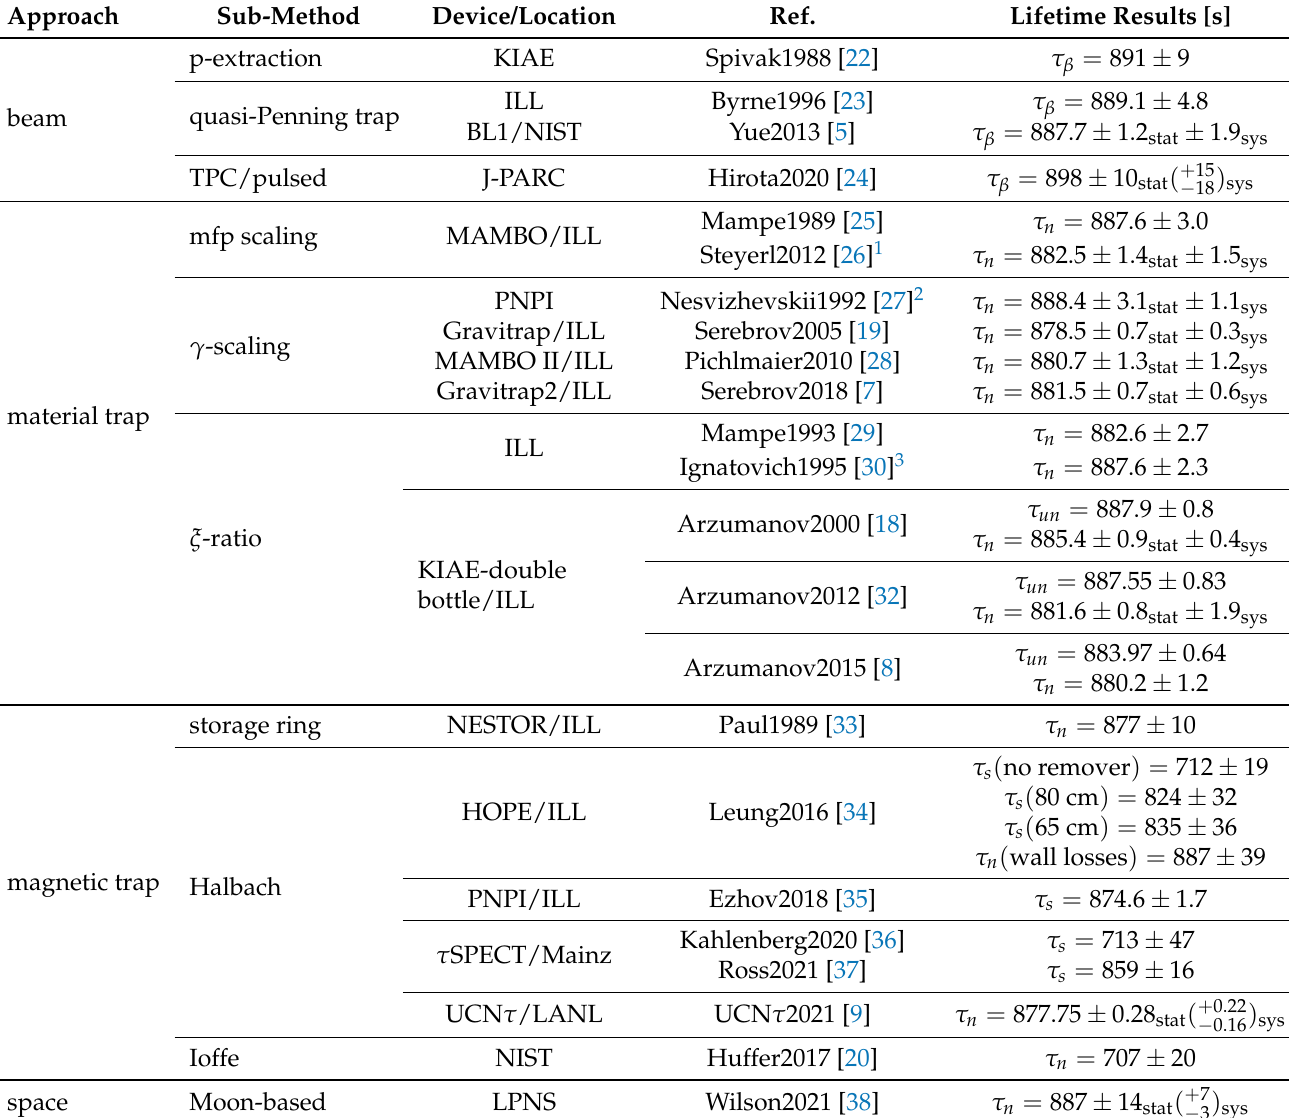
Table 1. Results of modern neutron lifetime measurements are compiled and categorized according to their applied methods. Quoted lifetime values include the following types: τ n —measured lifetime; τ β —beta decay lifetime for the “beam” approach; τ un —uncorrected lifetime; τ s —storage lifetime (without systematic corrections applied) for some magnetic trap